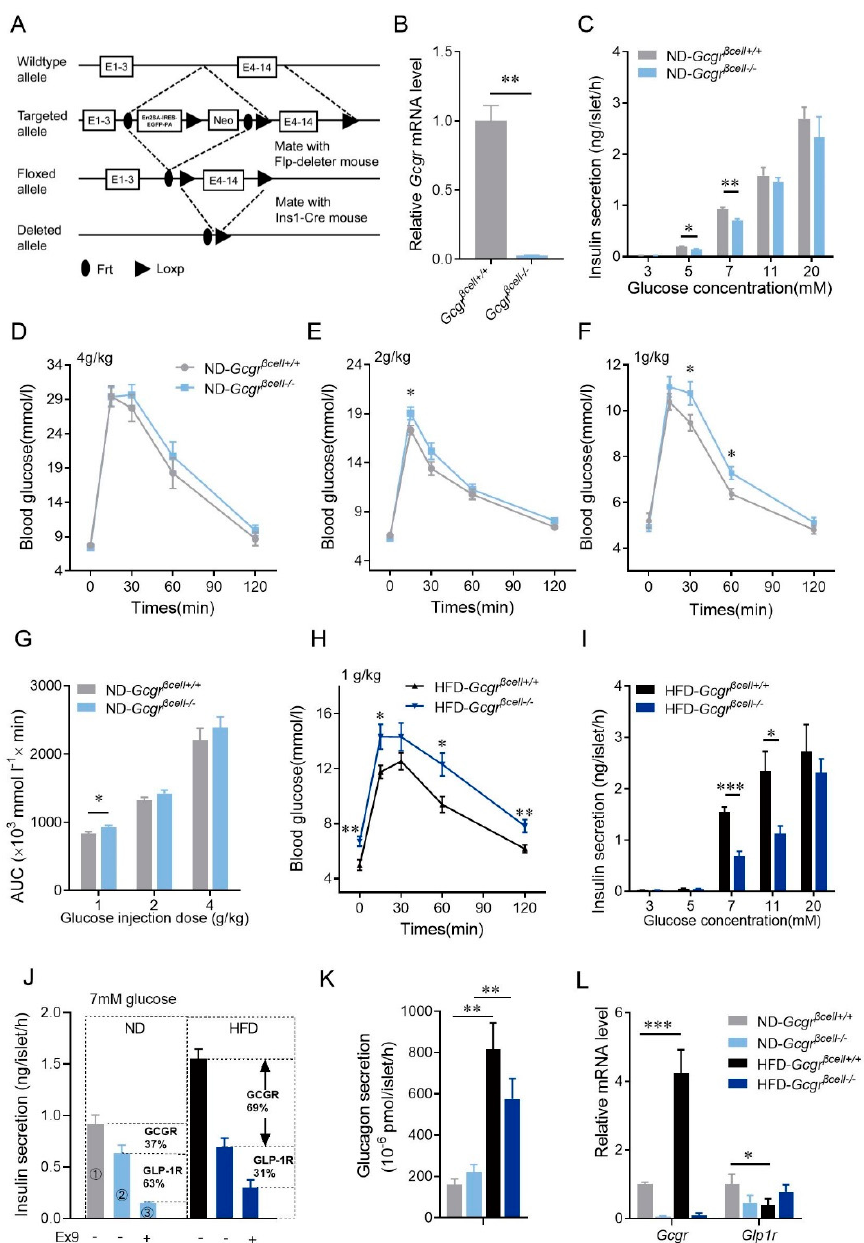
Figure 3. The physiological function of β -cell GCGR becomes upregulated and essential to glucose homeostasis in mice fed high-fat diets (HFD). ( A ) Schematic depicting the strategy for generating β -cell GCGR knockout mice. ( B ) Knockout efficiency of Gcgr mRNA in Gcgr β cell − / − mouse islets. ( C ) Insulin secretion of isolated islets from Gcgr β cell+/+ and Gcgr β cell − / − mice fed the normal diet (ND) at different glucose concentrations (3 mM, 5 mM, 7 mM, 11 mM and 20 mM) ( n = 5–9 per condition). ( D – F ) Intraperitoneal glucose tolerance tests (IPGTTs) on Gcgr β cell+/+ and Gcgr β cell − / − mice fed the ND in- jected with different doses of glucose. The glucose doses were 4 g/kg ( D ), 2 g/kg ( E ), and 1 g/kg ( F ) ( n = 12–14 mice per condition). ( G ) The areas under the curves (AUCs) of the intraperitoneal glucose tolerance tests (IPGTTs) on Gcgr β cell+/+ and Gcgr β cell − / − mice fed the ND injected with different doses of glucose (1 g/kg, 2 g/kg, and 4 g/kg) ( n = 12–14 mice per condition). ( H ) IPGTTs on Gcgr β cell+/+ and Gcgr β cell − / − mice fed the HFD injected with 1 g/kg glucose ( n = 12–15 mice per condition). ( I ) Insulin secretion of isolated islets from Gcgr β cell+/+ and Gcgr β cell − / − mice fed the HFD at different glucose con- centrations (3 mM, 5 mM, 7 mM, 11 mM and 20 mM) ( n = 5–9 per condition). ( J ) Contributions of GCGR and GLP-1R on insulin secretion of isolated islets from Gcgr β cell+/+ and Gcgr β cell − / − mice fed the